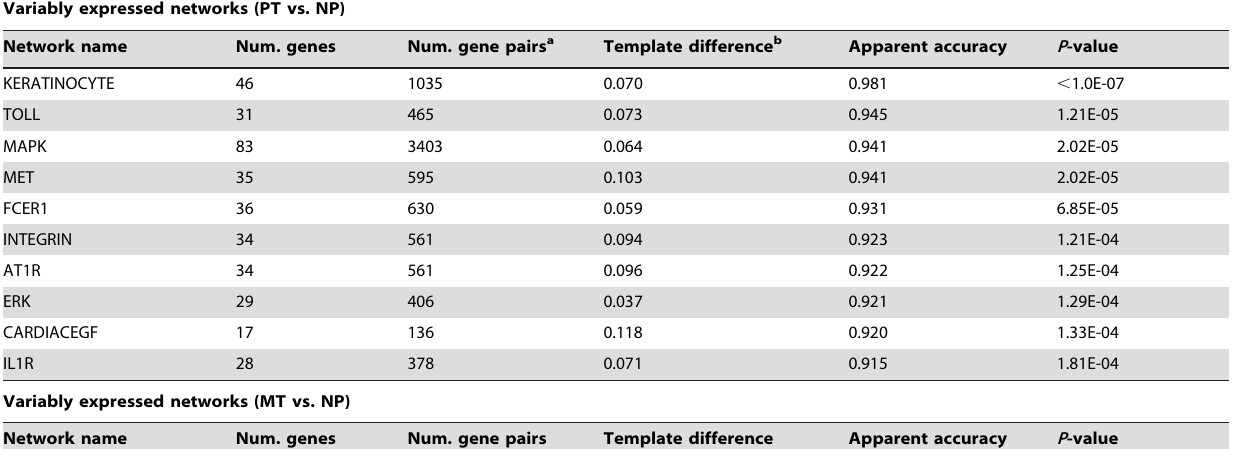
Variably expressed networks (PT vs. NP)